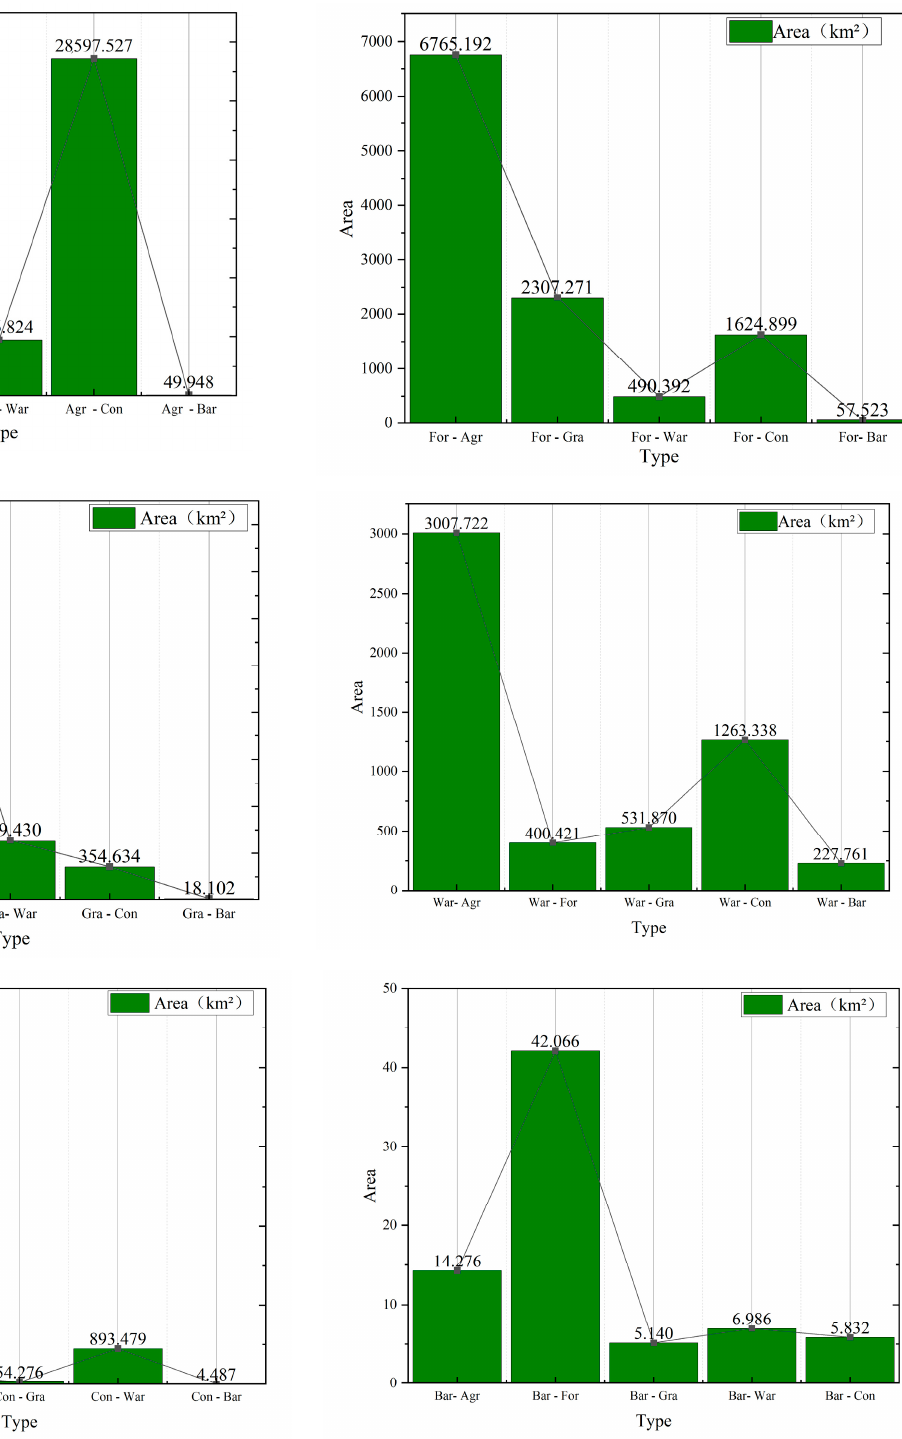
Figure A1. Changes in land use quantity of the Yangtze River Delta urban agglomeration from 1980 to 2020 (Agr, agriculture; For, forests; Gra, grass; War, Water; Con, Constructed; Bar, bare).